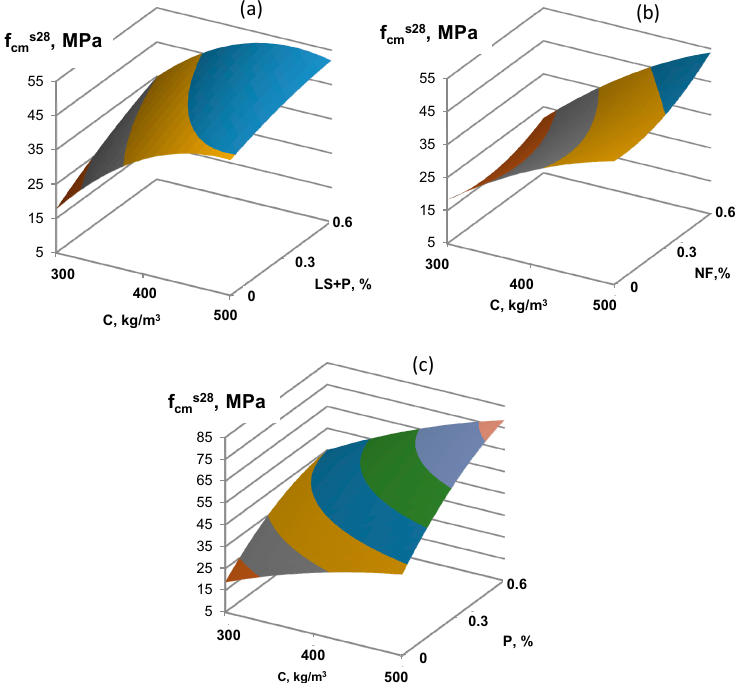
Figure 4. The combined effect of cement consumption and various types of superplasticizers (NF ( a ), P ( b ), and P+LS ( c )) on low-clinker slag Portland cement concrete strength after TMP and 28 days of normal hardening.